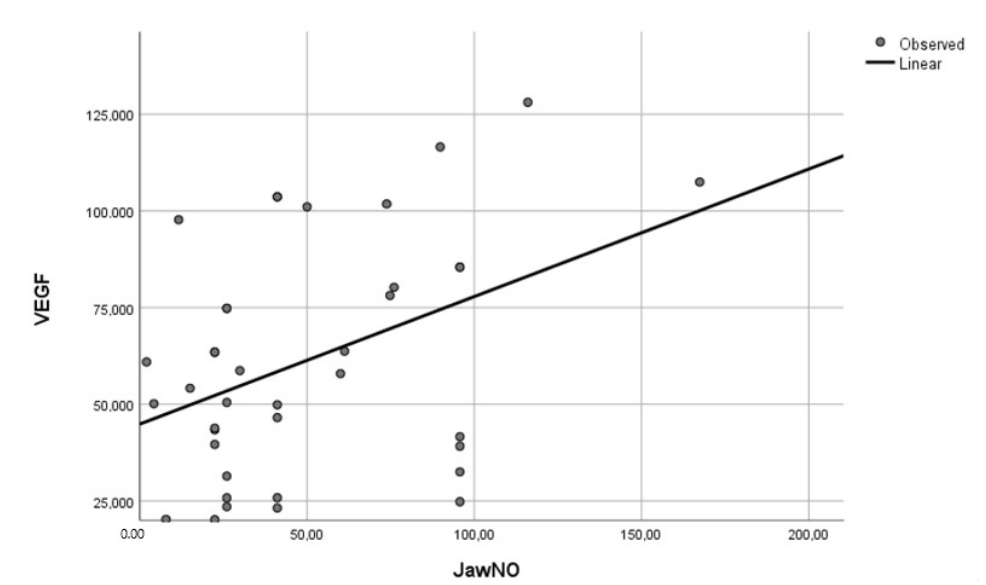
Figure 2. Correlation between VEGF in EBC and JaWNO in patients with